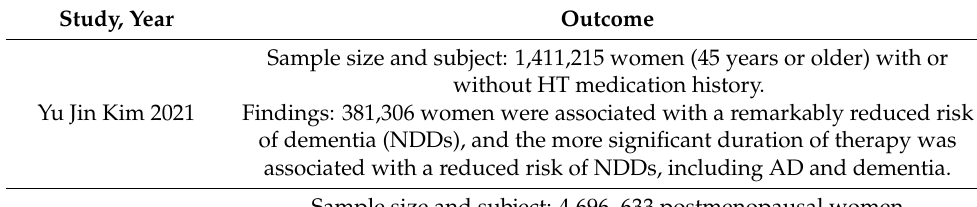
Table 4. Summary of studies on menopausal hormonal therapy (MHT). Study,